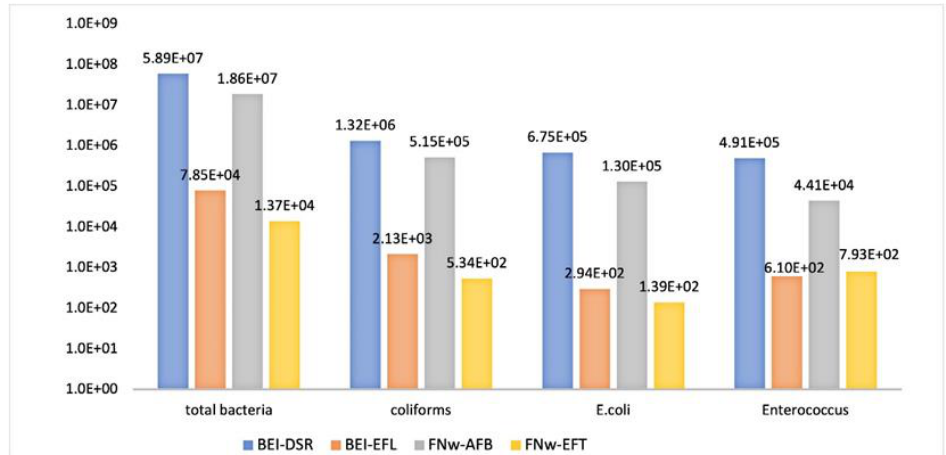
Figure 1. Microbiological analysis of 96 WWTP samples from the Beirolas-Lisboa and Faro Northwest-Algarve WWPTs of influent wastewater (BEI-DSR/FNw-ABF) and effluent wastewater (BEI-EFL/FNw-EFT), represented by the average numbers obtained for total aerobic bacteria, coliforms, Escherichia coli, and Enterococcus spp.